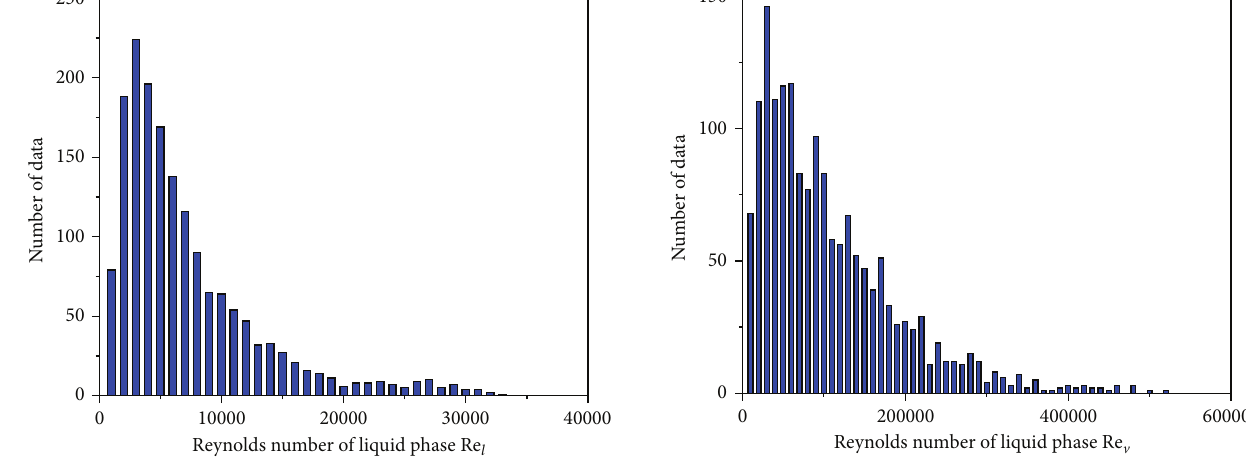
Figure 2: Liquid Reynolds number Re 𝑙 distribution. Figure 3: Vapor Reynolds number Re V